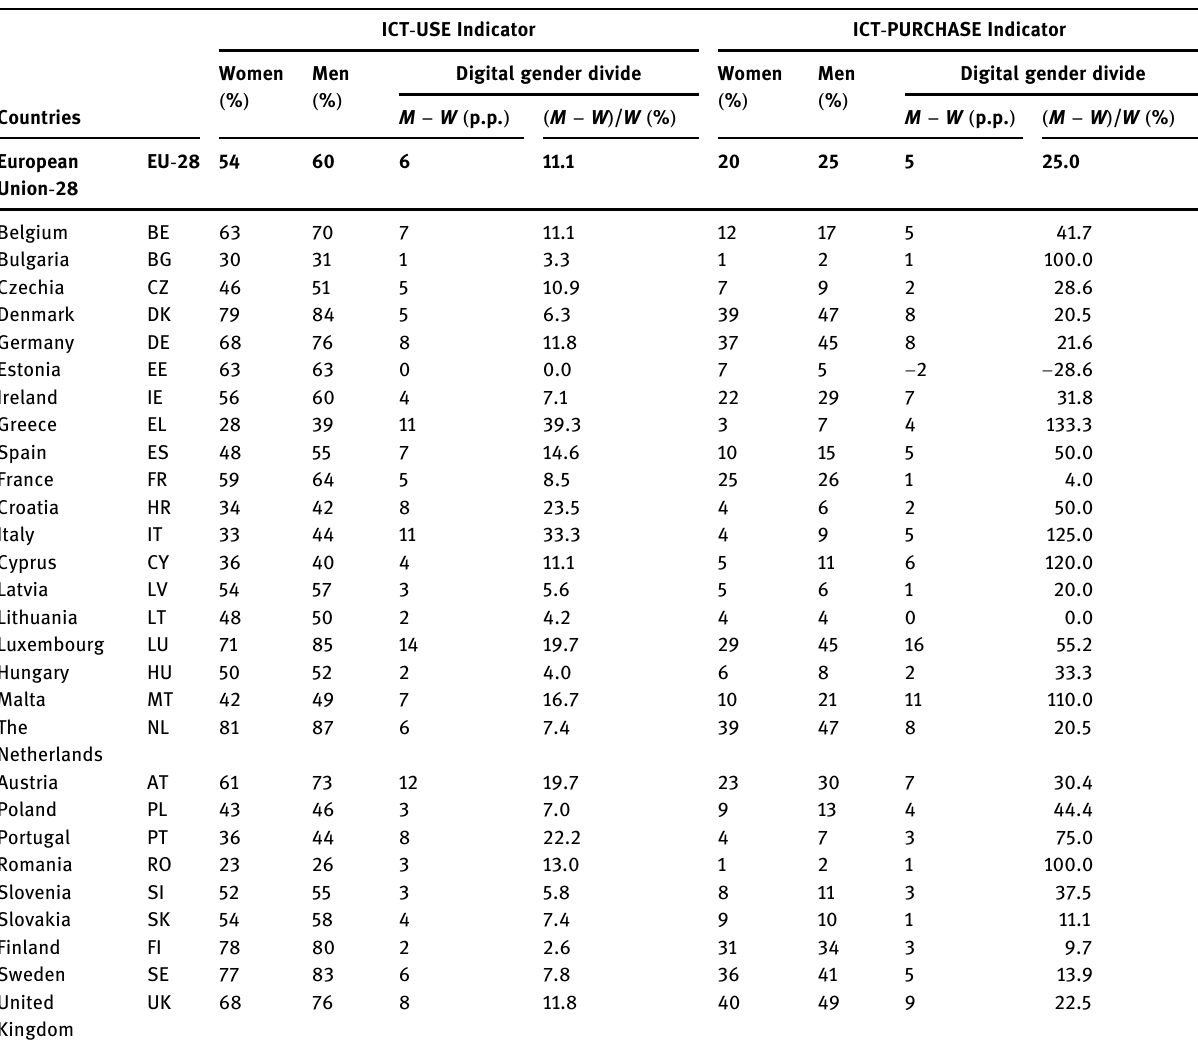
Table 2: ICT indicators and the digital gender,